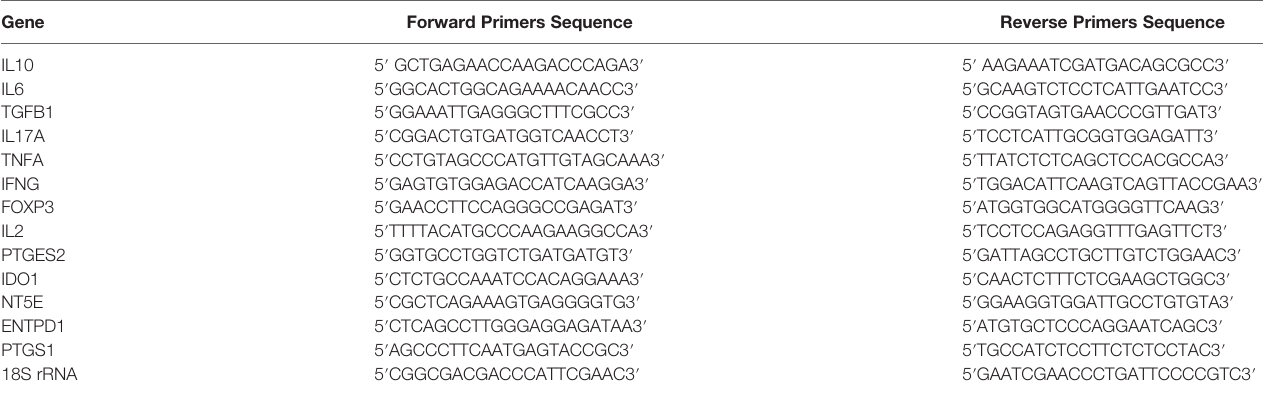
TABLE 2 | qPCR primer sequences of immunostimulatory and immunomodulatory genes that are involved in the immunoregulatory effect of primed